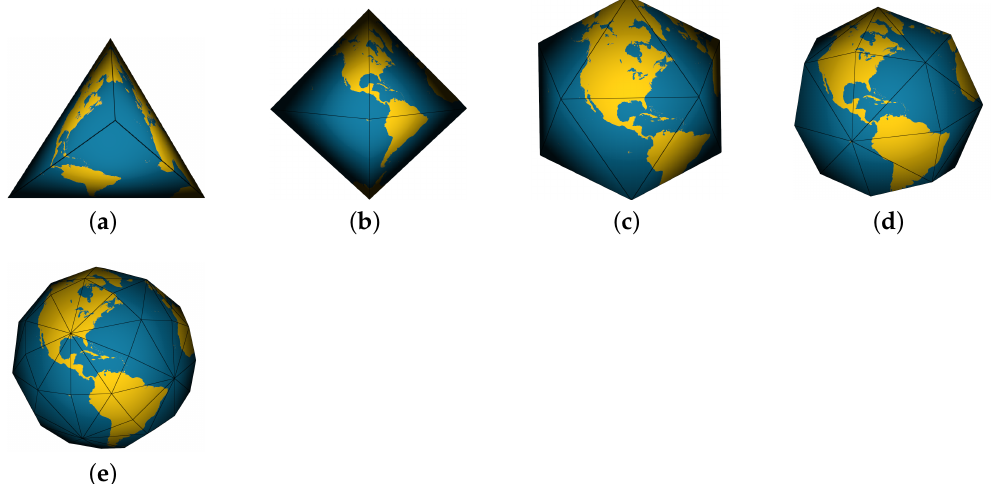
Figure 3. ( a ) Tetrahedron ( b ) Octahedron ( c ) Icosahedron ( d ) Disdyakis dodecahedron ( e ) Disdyakis triacontahedron.